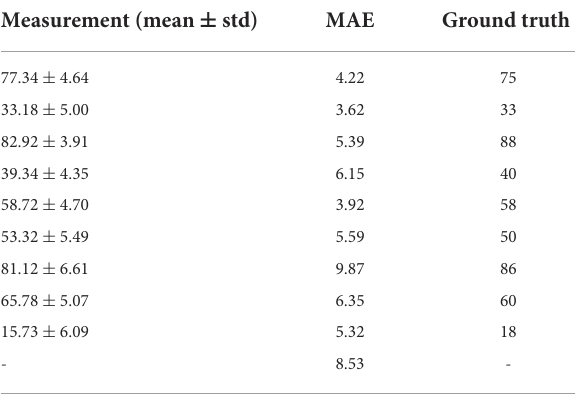
TABLE 2 Curvature angle estimation algorithms performance